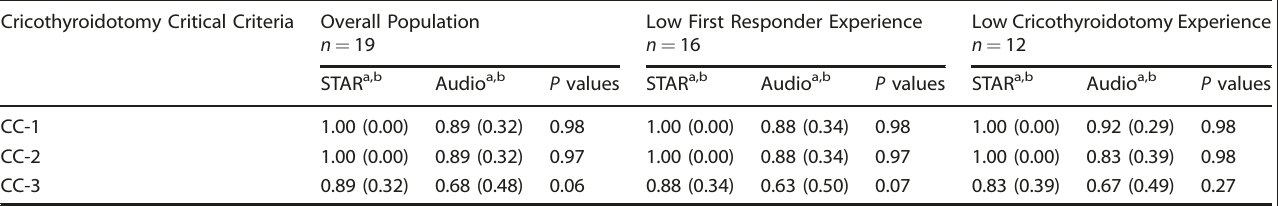
Table 4. Averaged results for the different criteria of the Critical Criteria metric for the Overall Population and both the experience-based subgroups. Cricothyroidotomy Critical